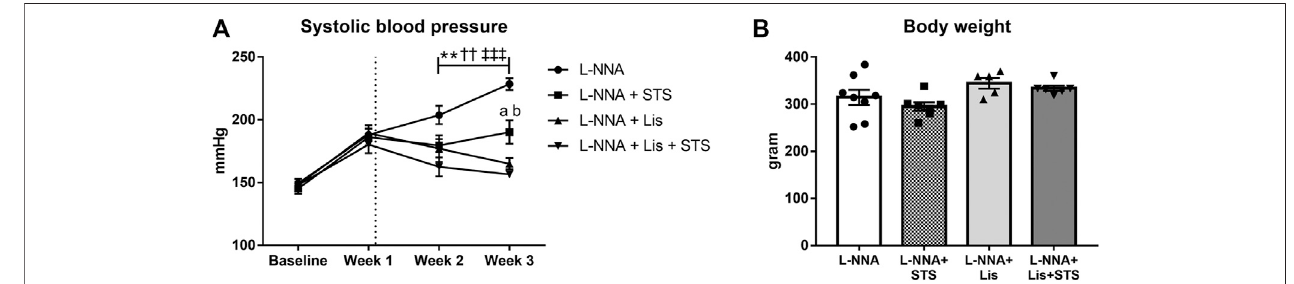
FIGURE1| STSadministrationdecreasessystolicbloodpressure. (A) Longitudinalmeasurementsofsystolicbloodpressureand (B) bodyweightattheendofthe experimental protocol are shown for the four groups. N (cid:2) 5 – 8. *L-NNA vs. L-NNA + STS, † L-NNA vs. L-NNA + Lis, ‡ L-NNA vs. L-NNA + Lis + STS, a L-NNA + Lis vs.